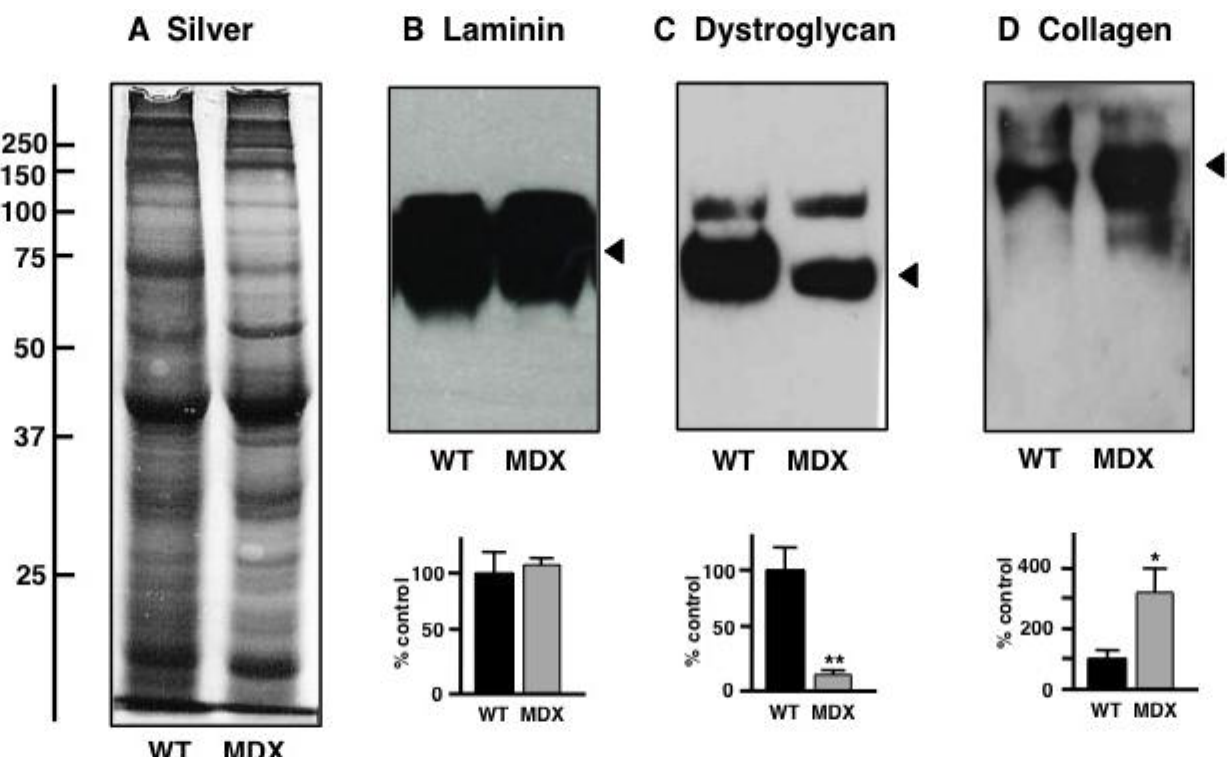
Figure 7. Gel electrophoretic and immunoblot analysis of the aged mdx diaphragm muscle: Shown is a silver-stained gel ( A ) and representative immunoblots ( B (cid:177) D ) with expanded views of antibody-decorated bands. Lanes 1 and 2 represent preparations from non-dystrophic wild type (WT) versus dystrophic (MDX) diaphragm muscle, respectively. Immuno-decoration was carried out with primary antibodies to laminin ( B ), the dystrophin-associated glycoprotein (cid:533) -dystroglycan ( C ) and collagen ( D ). Below the individual immunoblots are shown panels, which give a graphical representation of the immuno-decoration levels in normal versus mdx (cid:83)(cid:85)(cid:72)(cid:83)(cid:68)(cid:85)(cid:68)(cid:87)(cid:76)(cid:82)(cid:81)(cid:86)(cid:3) (cid:11)(cid:54)(cid:87)(cid:88)(cid:71)(cid:72)(cid:81)(cid:87)(cid:182)(cid:86)(cid:3) t -test, unpaired; n = 4; * p < 0.05; ** p <